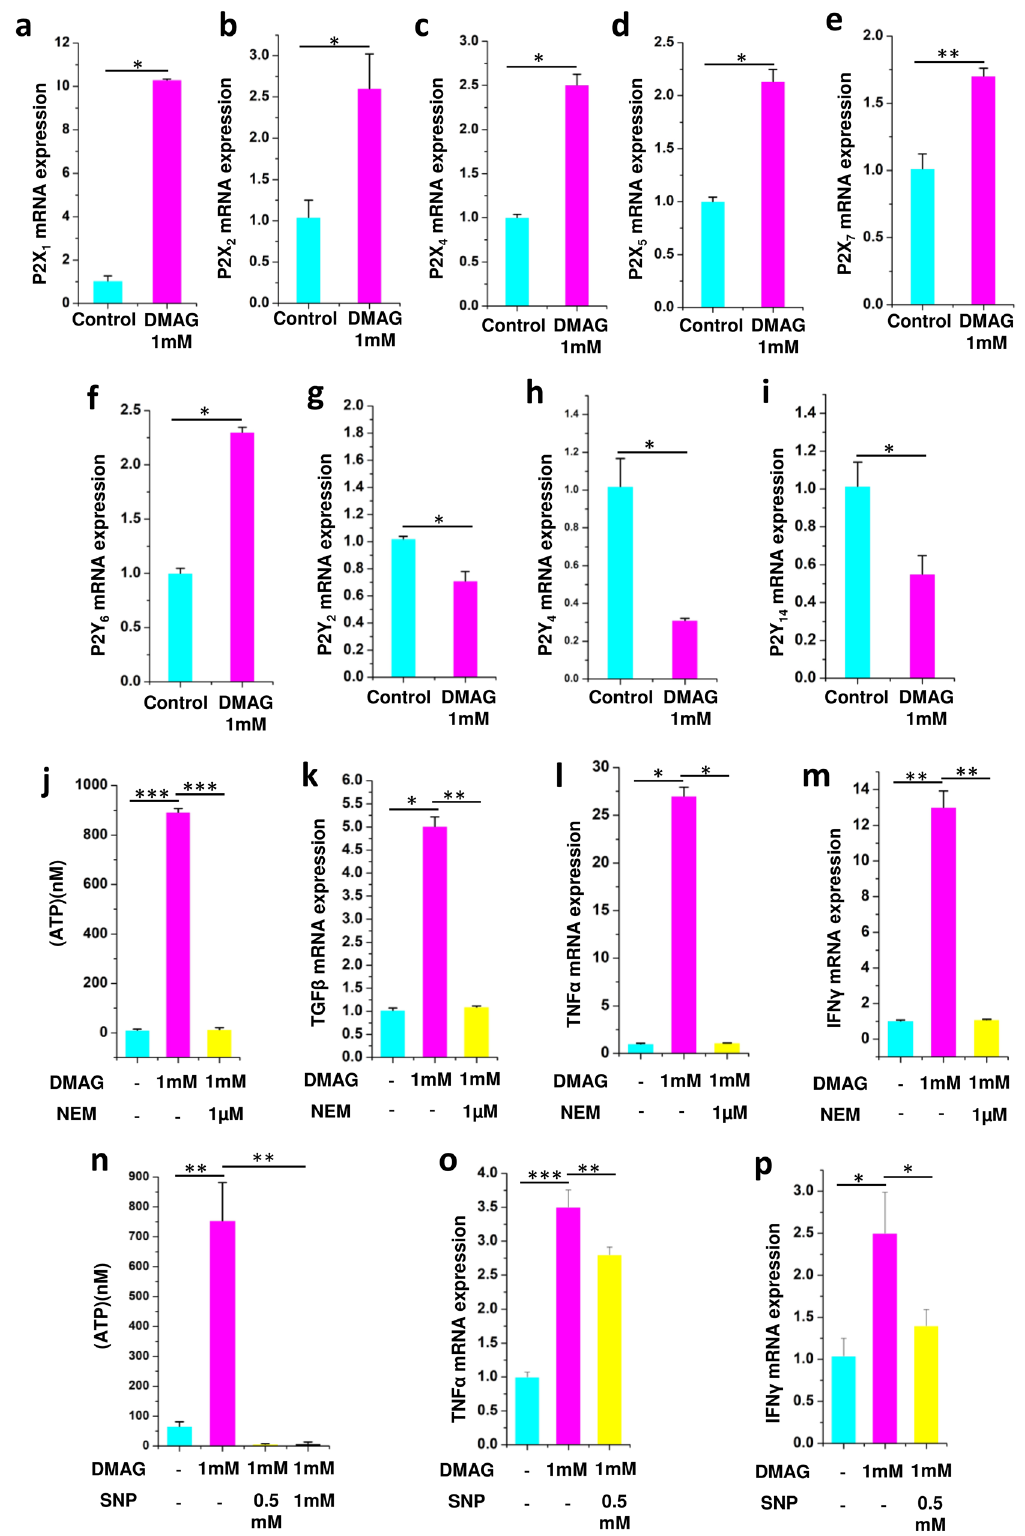
Figure 3. Showing expression of P2 receptors in N9 microglial cells and DMAG induced ATP secretion and expression of cytokines as well as effect of NEM and sodium nitroprusside (SNP) showing ( a – i ) N9 cells treated with DMAG inducing the expression of P2X receptors and P2Y receptors ( a ) P2X 1 ( b ) P2X 2 ( c ) P2X 4 ( d ) P2X 5 ( e ) P2X 7 ( f ) P2Y 6 ( g ) P2Y 2 ( h ) P2Y 4 ( i ) P2Y 14 . Showing N9 cells treated with DMAG (1 mM) with or without pre-incubation with NEM (1 μM) ( j ) Secretion of ATP and inhibited by NEM. Showing upregulation of cytokines and inhibition by NEM ( k ) TGFβ ( l ) TNFα ( m ) IFN ɣ . Showing N9 cells treated with DMAG (1 mM) with or without pre-incubation with SNP (0.5 mM and 1 mM) ( n ) secretion of ATP and its inhibition by SNP. Showing upregulation of cytokines and inhibition by SNP ( o ) TNFα ( p ) IFNy. The significance was calculated using Student T-test. * for P < 0.05, ** for P < 0.01, and *** for P < 0.001. For n numbers and the results provided as mean ± SEM, refer to